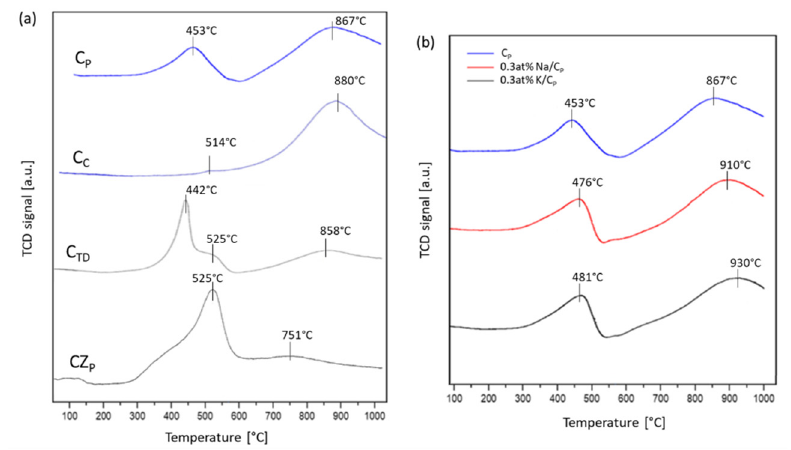
Figure 4. Temperature-programmed reduction profiles of ( a ) all three types of ceria and the cerium– zirconium mixed oxide and ( b ) precipitated ceria support after K + or Na + ion deposition.